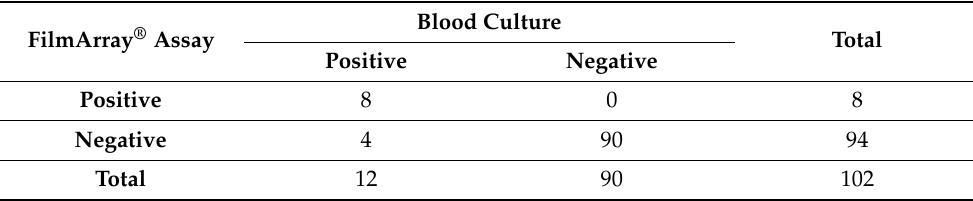
Table 3. Positive and negative results of blood cultures and the FilmArray ® BCID panel in 102